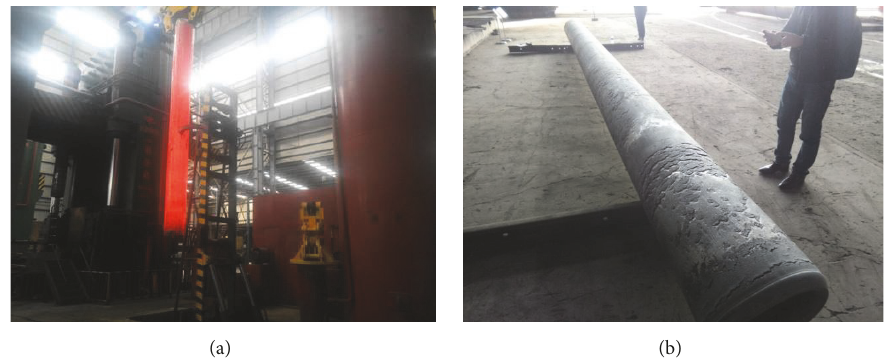
Figure 17: The extruded pipe under the extrusion process (a); after the extrusion